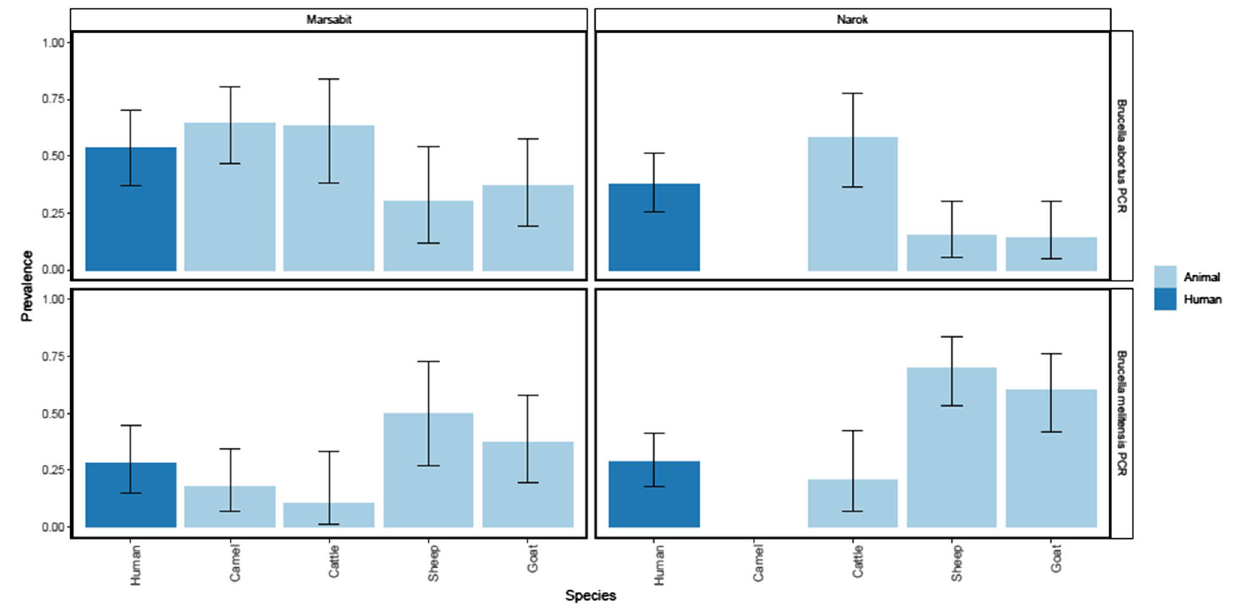
Figure 2. Graphical presentation of the proportion of each host species testing positive for B. abortus and B. melitensis in Narok and Marsabit. The four panels show data for each site and Brucella species respectively. In each panel the bars indicate the proportion of each species testing positive. The error bars indicate exact binomial confidence